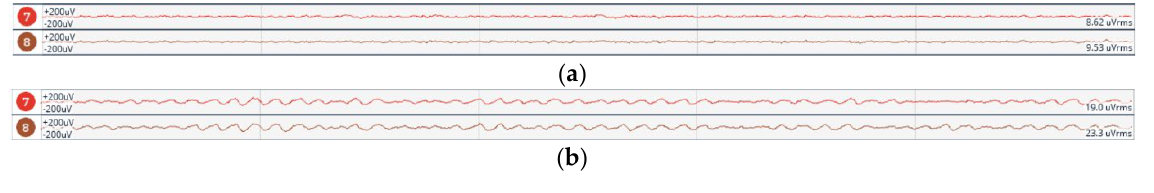
Figure 11. Rhythmic activity during photic simulation. ( a ) Non-photic; ( b ) photic.